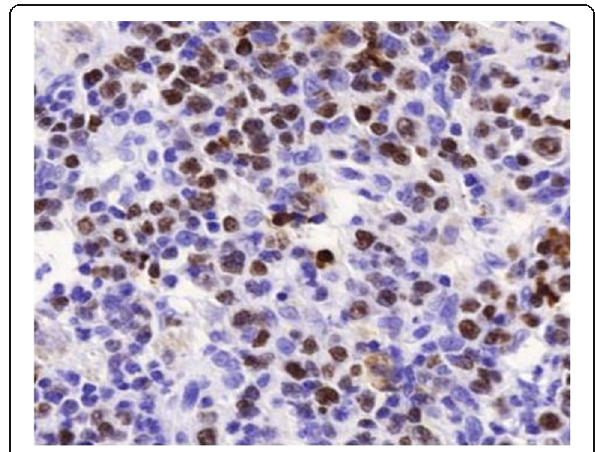
Fig. 2 Ki67 positive nuclear immunoreactivity for the count (brown colour)